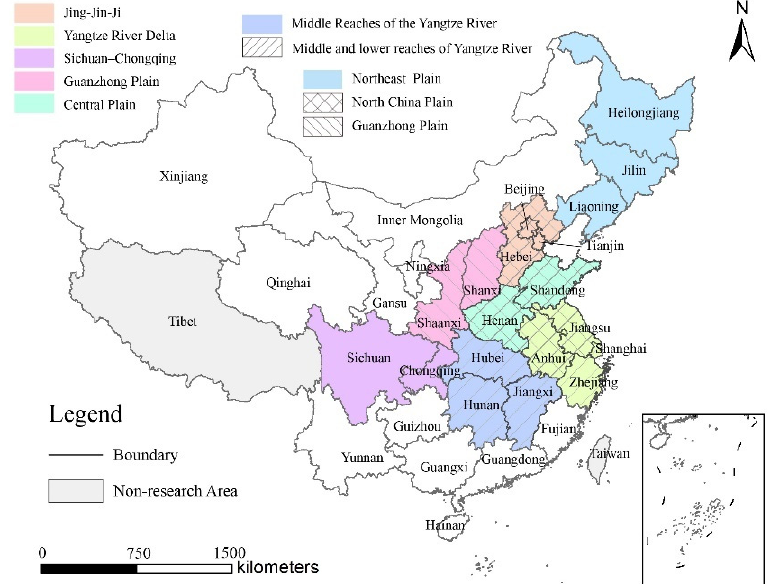
Figure 1. Provinces, six national-level urban agglomerations and four plains.